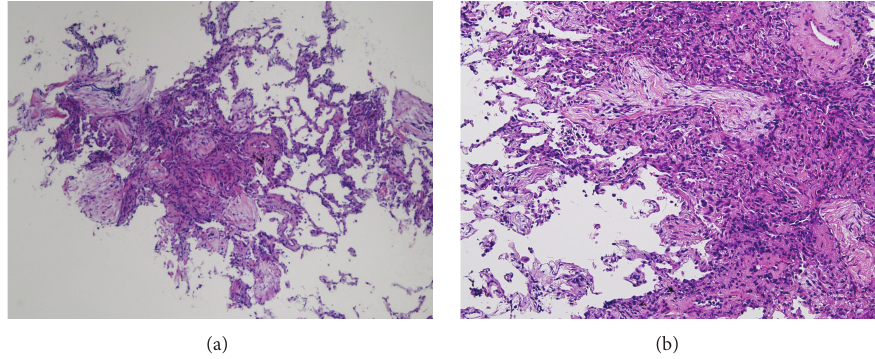
Figure 2: Pathologic examinations of transbronchial lung biopsy specimen with hematoxylin and eosin stain ((a) × 40 and (b) × 100) show intra-alveolar buds of granulation tissue and fibrous thickening of the alveolar wall.